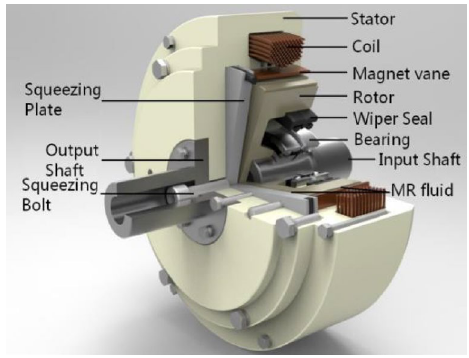
Figure 1. The schematic of the compression-shear type MR